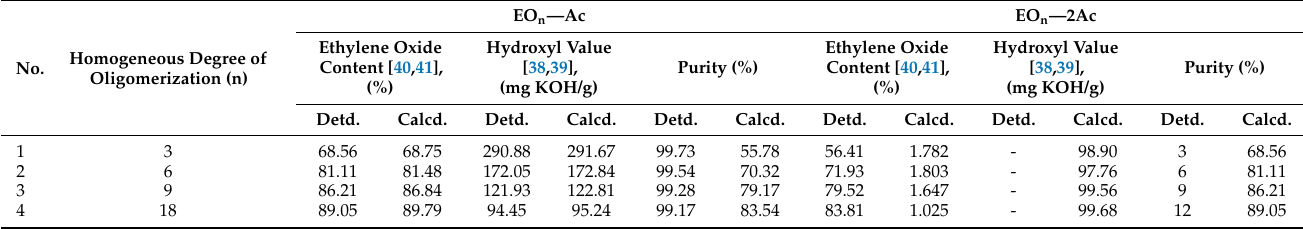
Table 9. The main chemical characteristics of several homogeneous polyoxyethylene chains (EO) n n = 3, 6, 9, 18 mono- (EO) n —Ac) and diprotected (EO n —2Ac) by acetylation.